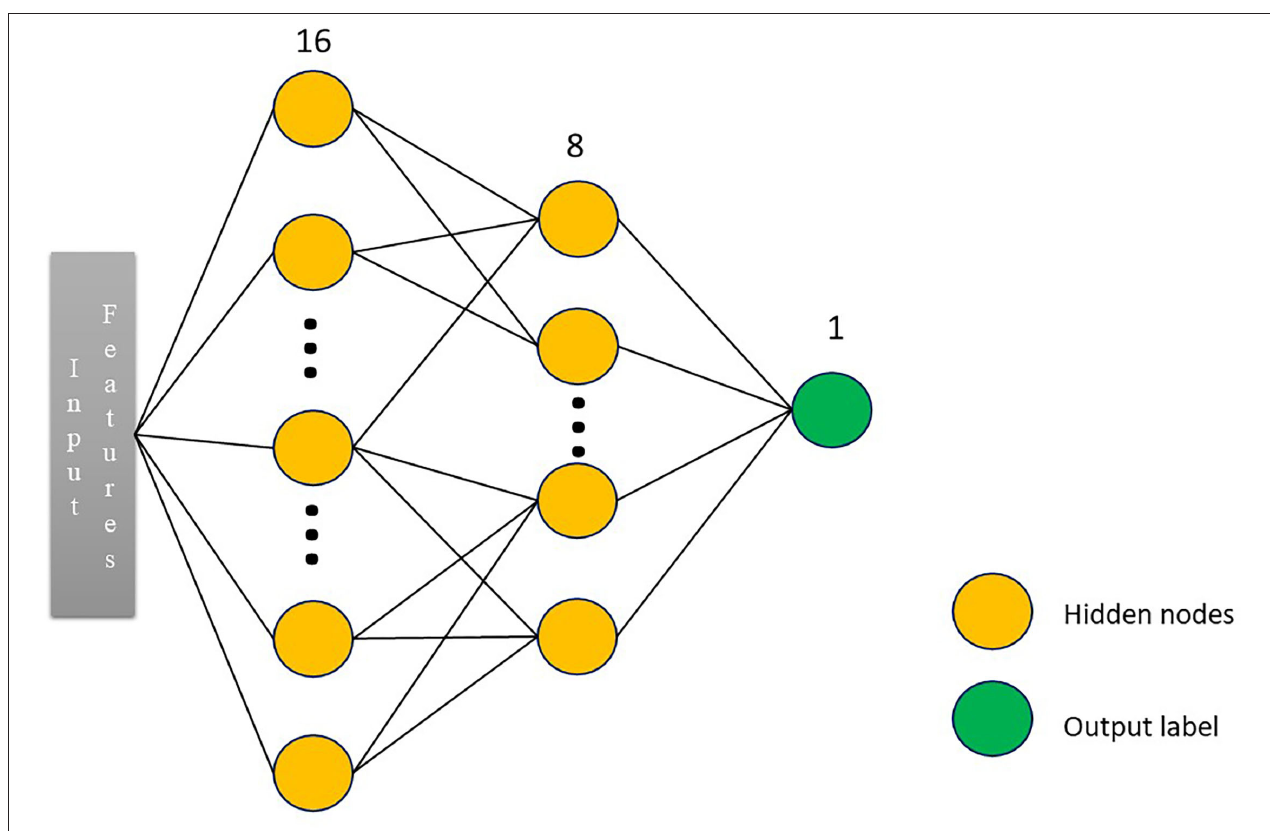
FIGURE 3 | The overall architecture of the neural network. We constructed a three-layer multilayer perceptron (MLP) network classifier. The input was the radiomic features. The number of nodes for two hidden layers was set to 16 and 8, respectively. The number of nodes for output layer was set to 2, the same as the number of patient’s